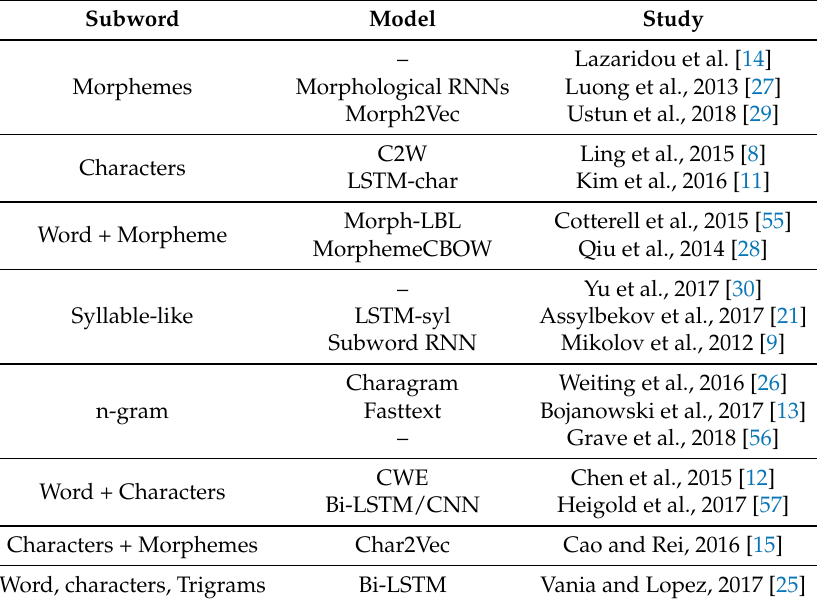
Table 2. The various compositional models for word